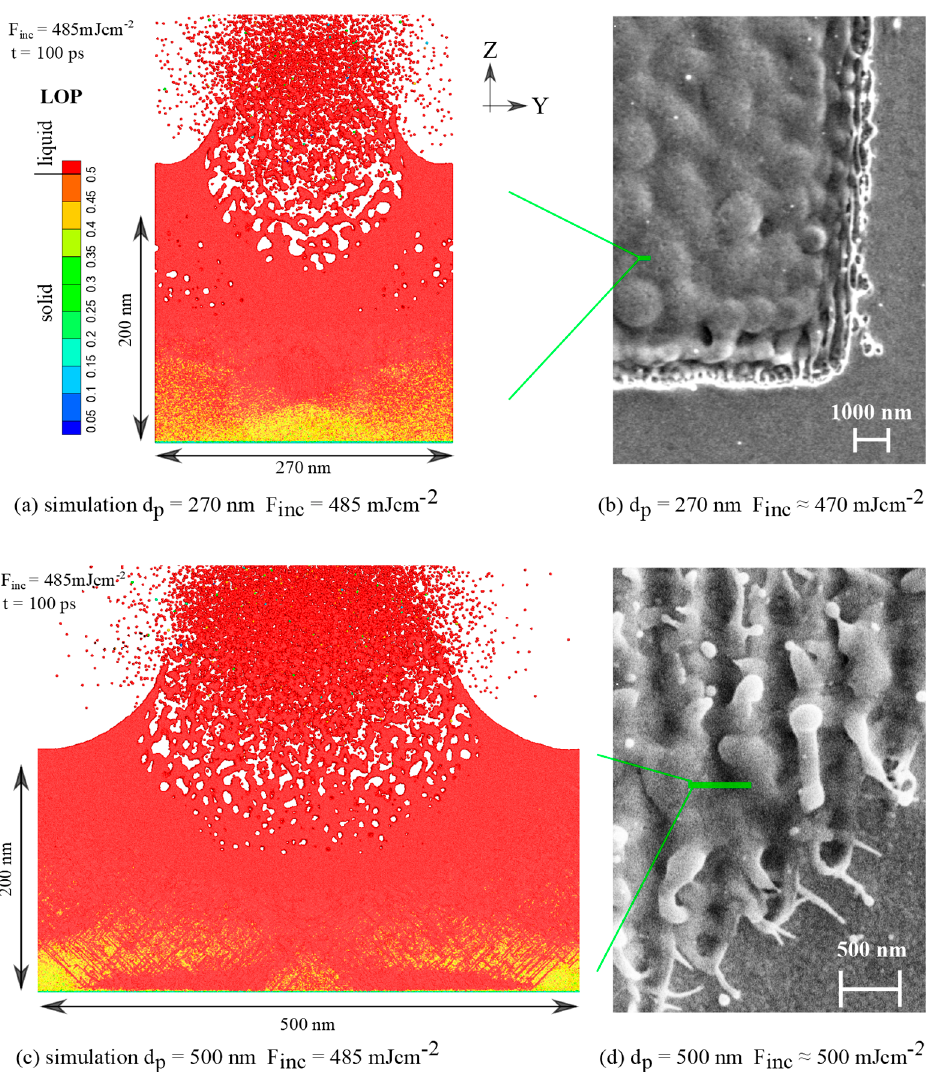
Figure 8. ( a ) Direct comparison of the simulation results of 270-nm period nanostructuring at a high incident fluence of 485 mJ/cm 2 with ( b ) the experimental data obtained for 470 mJ/cm 2 . ( c ) Direct comparison of the simulation results of 500-nm period nanostructuring at a high incident fluence of 485 mJ/cm 2 with ( d ) the experimental data obtained for 500 mJ/cm 2 . The atoms are colored by local order parameter (LOP) used here for identification of the extremely fast melting process. The liquid phase is characterized by a rapid jump of LOP above cut-off value 0.5.